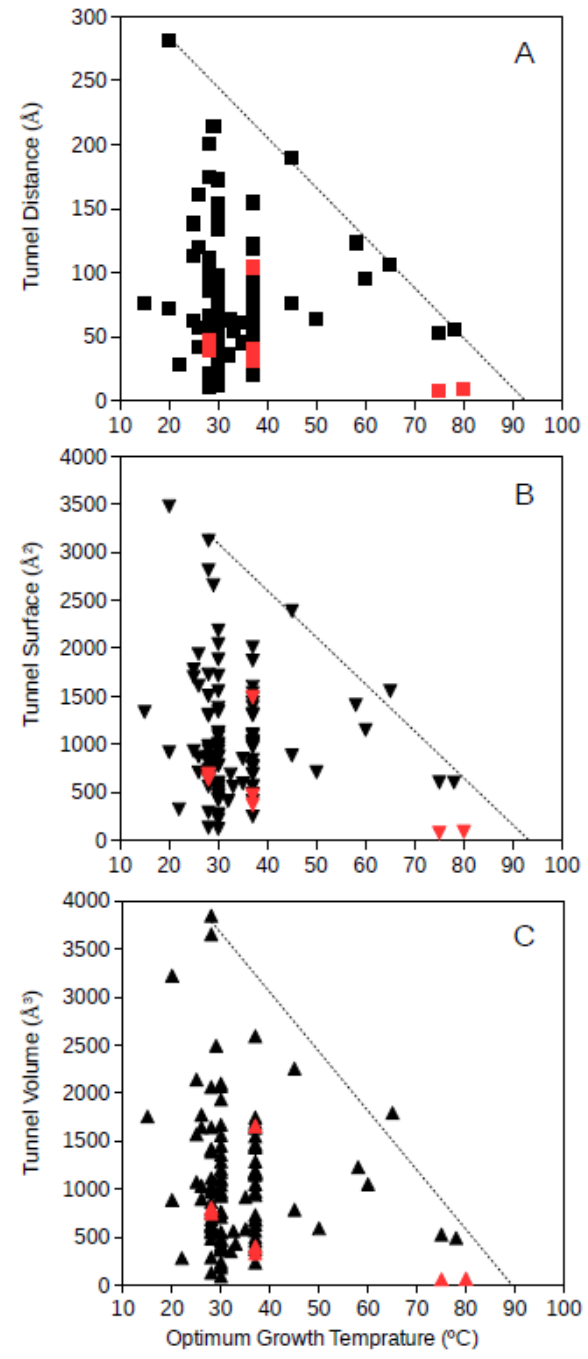
Figure 1. Tunnel distance ( A ), surface ( B ) and volume ( C ) (in Å) dimensions predicted for bacteria GDHs (Glutamate dehydrogenase) ranging in optimum growth temperature from 15 °C to 99 °C. Grey line represents a visualization of the upper limit for these dimensions at increasing temperatures. Black symbols correspond to predicted protein structures; red symbols correspond to resolved model structures from the Protein Data Bank.